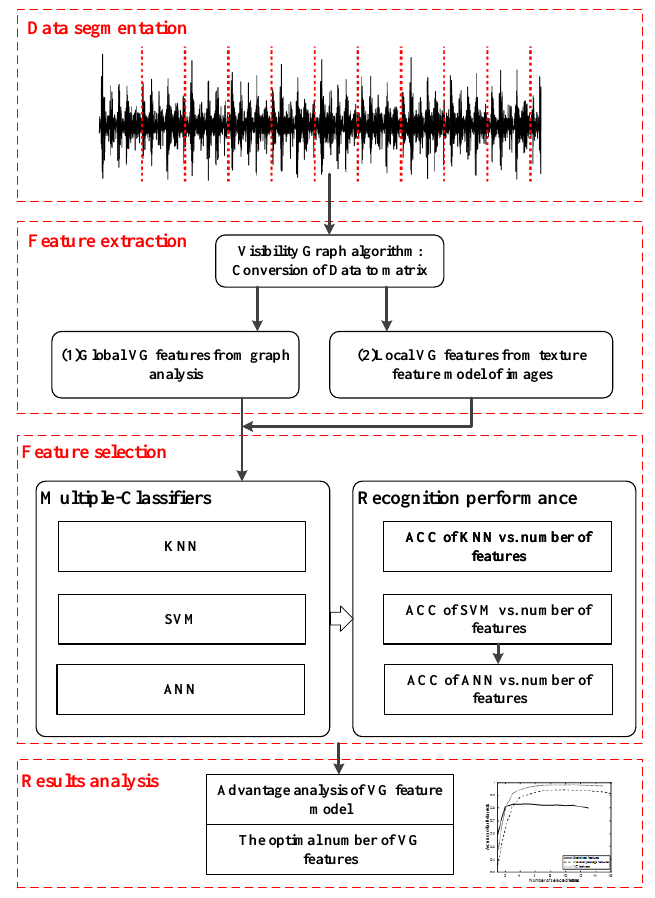
Figure 1. Framework of the VG feature model for bearing fault